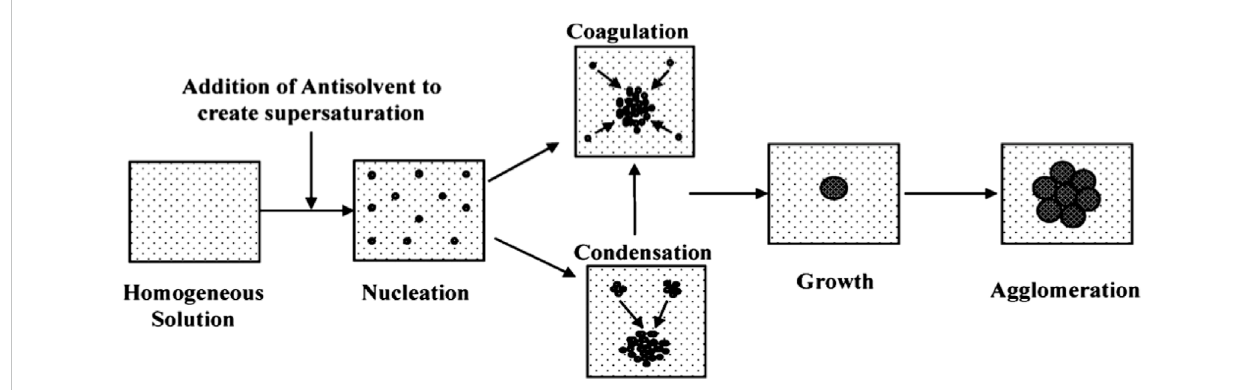
SCHEME 2 Schematic diagram of the particle precipitation process.